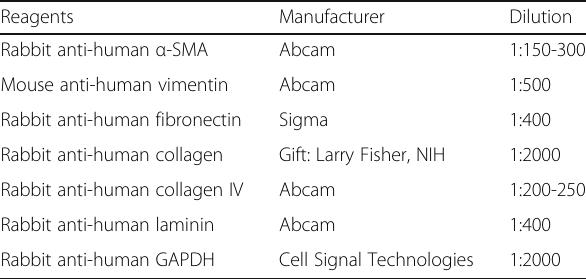
Table 1 Antibodies. Dilutions and manufacturer information for antibodies used for western blot experiments